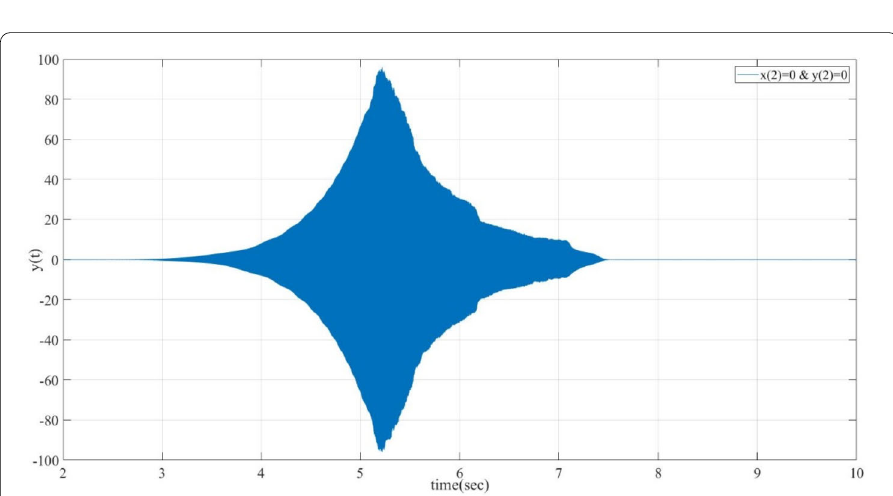
Figure 2 Trajectory of y ( t ) for Example 1 when x (2) = 0 and y (2) = 0